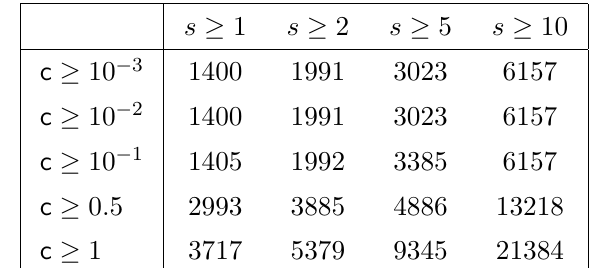
Figure 3 . Dependence of N flux on the dilaton s . Note that N flux is shown on a logarithmic scale. The blue data points are solutions with f 0 6 = 0 or h 0 6 = 0 , the orange data points are solutions with f 0 = h 0 = 0 , and the red curve is the lower bound on N flux shown in equation (5.2).